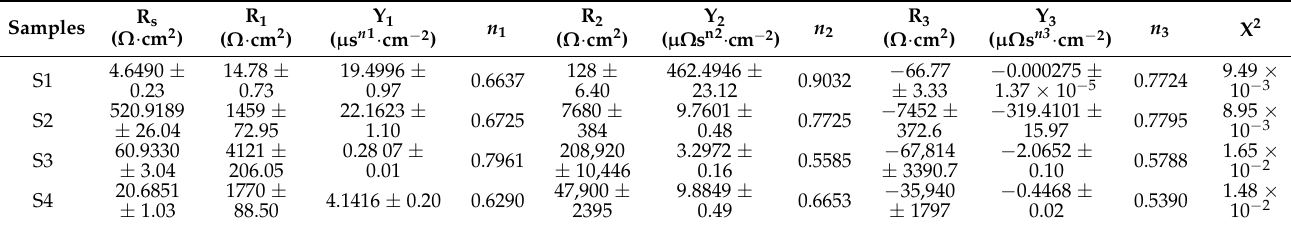
Table 3. EIS measurements obtained by EEC simulation of AA2055 aluminum-lithium